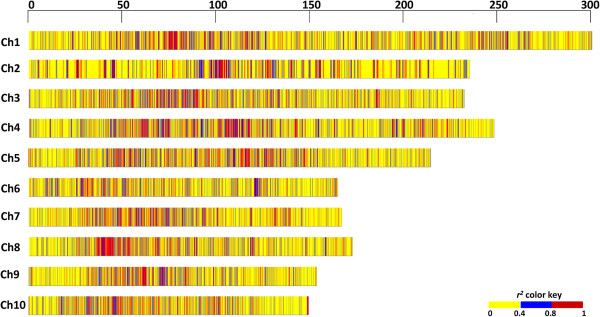
The distribution of low (r2≤ 0.4), intermediate (0.4 <r2<0.8), and high (r2≥ 0.8) pairwise LD regions along the chromosomes. The pairwise LD pattern was measured using SNPs with a MAF of ≥0.05 across the maize association mapping panel. The length of the chromosomes is shown in Mb.